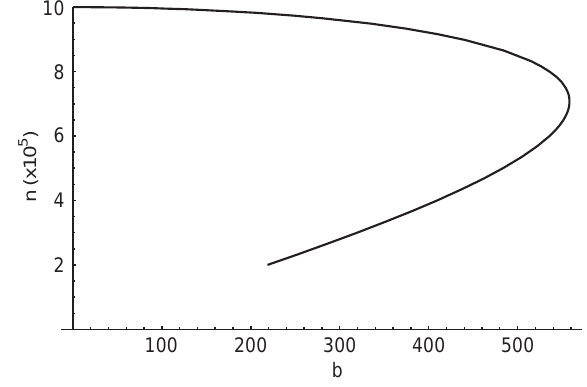
Fig. 10. Behavior of